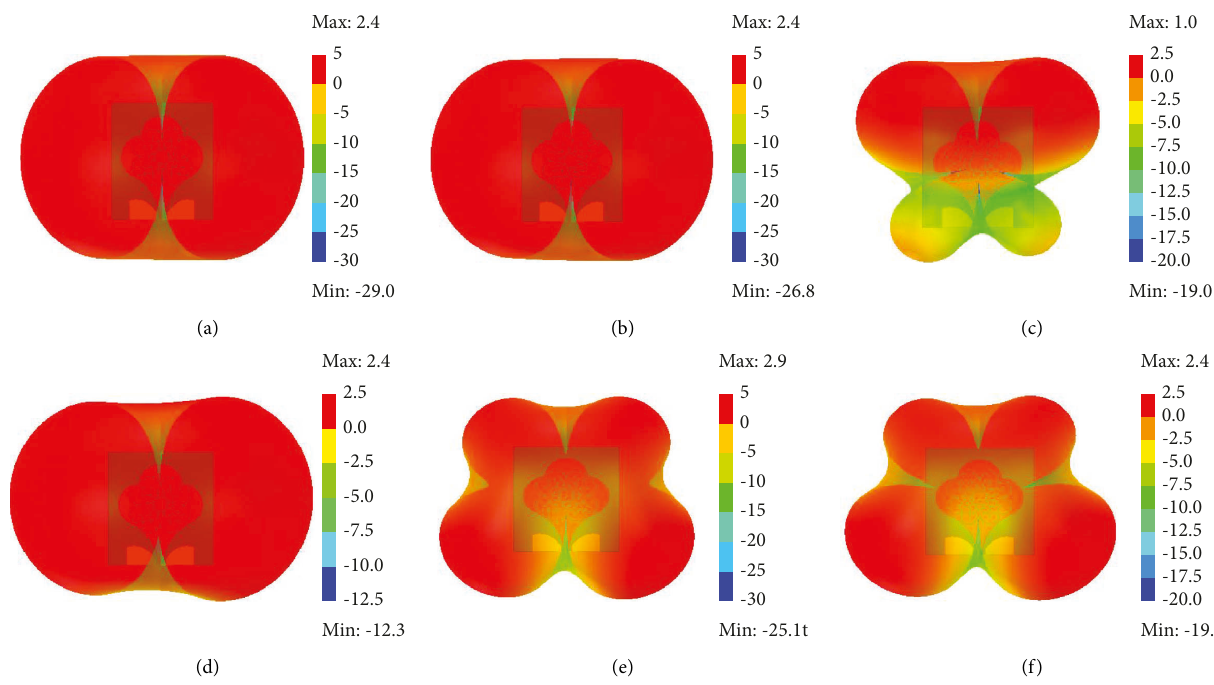
Figure 9: 3D radiation patterns at (a) 2.25GHz, (b) 2.5 GHz, (c) 3.1GHz, (d) 3.55GHz, (e) 5.7GHz, and (f) 6